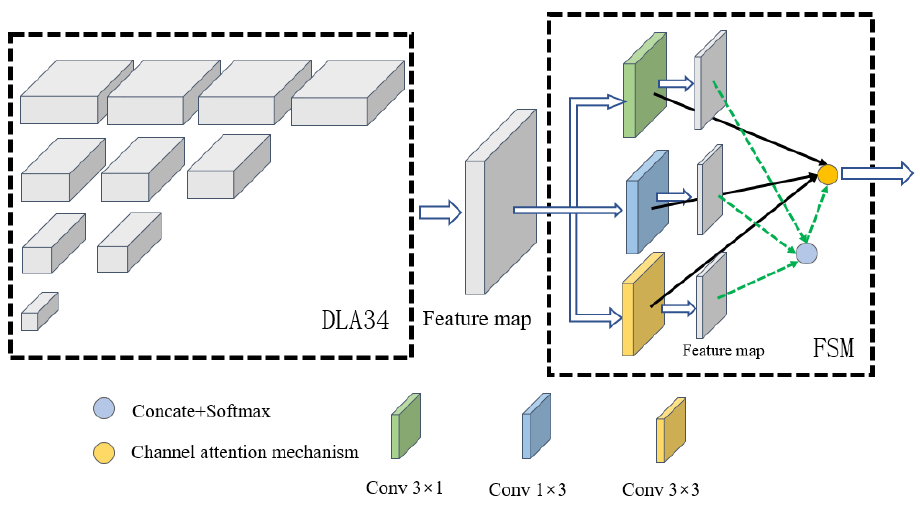
Figure 12. Feature extraction network (Dla34 + FSM).